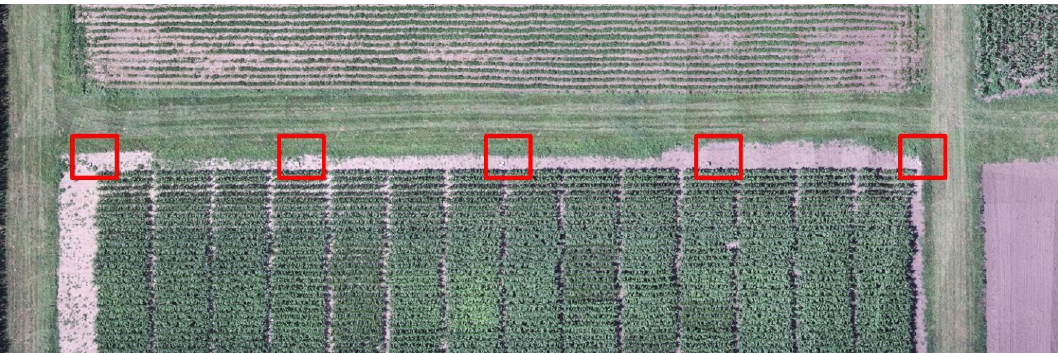
Figure 22. Orthophoto result ignoring the time delay using the refined trajectory data for FLIR RGB July 25th data collection (red boxes show the location of the check points, Original Image GSD ≈ 0.01 m ).